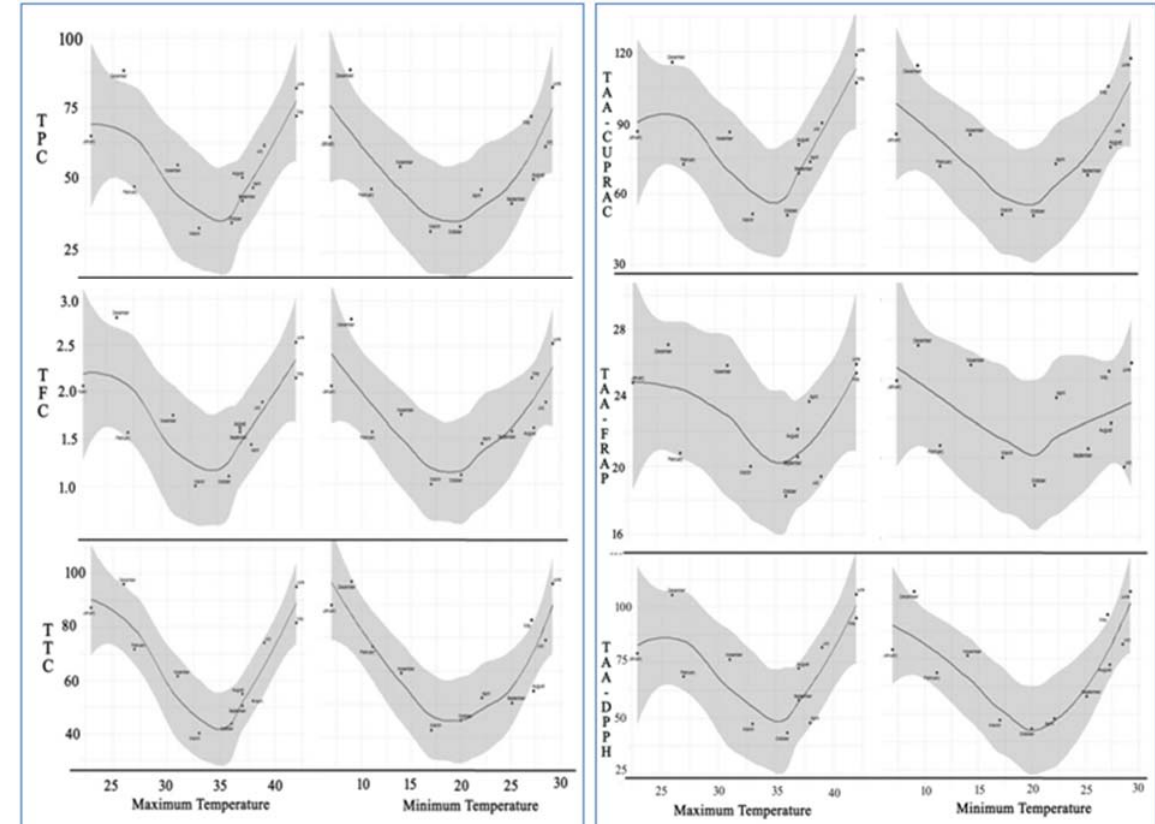
Figure 4. LOESS regression fitting of seasonal variation in TPC, TFC, TTC and total antioxidant activities (TAA.CUPRAC) of C. polygonoides foliage against maximum and minimum average monthly temperature.